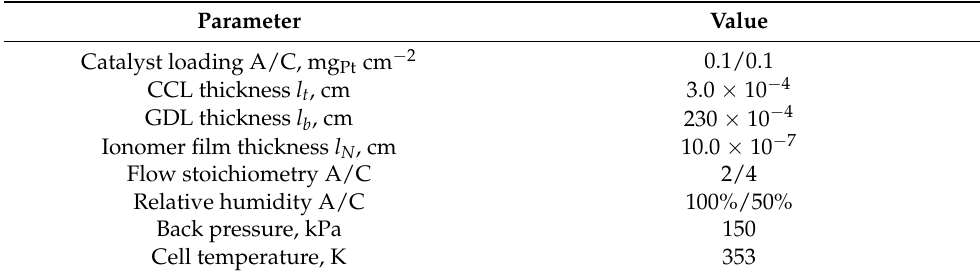
Table 1. Cell and operating parameters. A/C stands for